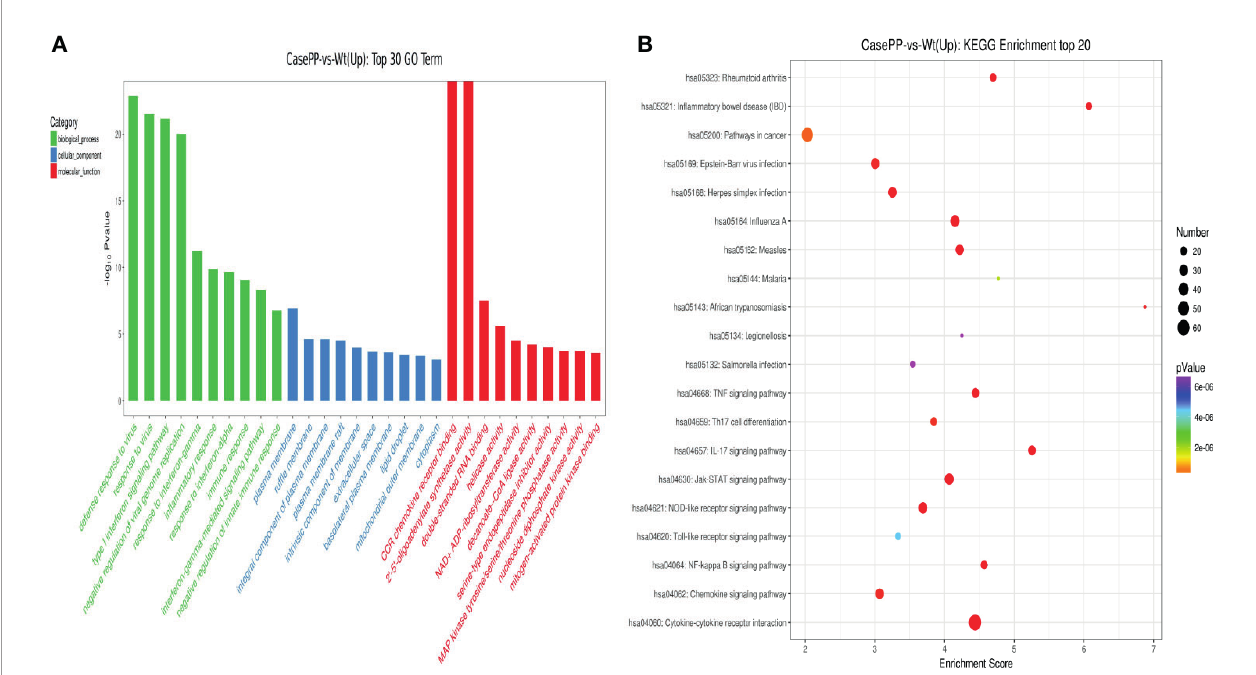
FIGURE 3 | GO annotations and KEGG pathway analysis results for upregulated DEGs. (A) The top 30 biological process, cellular component, and molecular function GO terms are shown (P < 0.05; unique gene number of GO terms > 2). (B) The top 20 KEGG pathways with positive enrichment are shown in a bubble chart with enriched pathways on the y- axis and enrichment scores on the x -axis. A positive correlation between bubble size and the number of pathway-related genes was observed, with a larger pathway enrichment P- value being associated with an increase in the red coloration of that